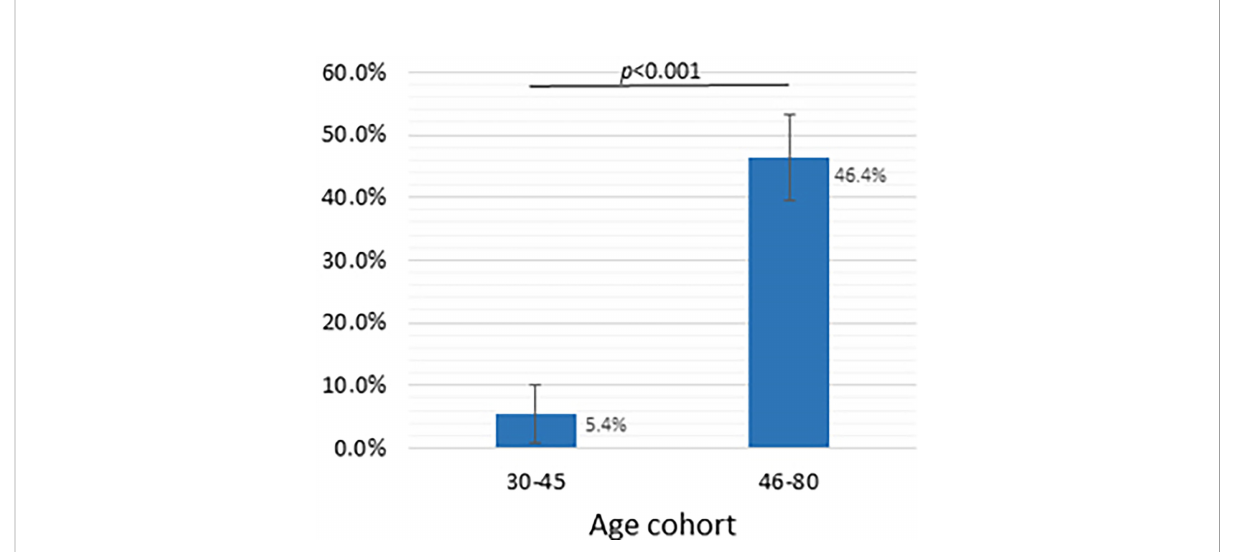
FIGURE 3 Dependence of the presence of viral neutralizing activity of blood serum sample on the age group, dilution - 1/20 and more. Y-axis shows the frequency of samples with VNA ≥ 1/20 (%), whiskers show a 95% con fi dence interval calculated by the Wald method. Two groups compared using chi-square